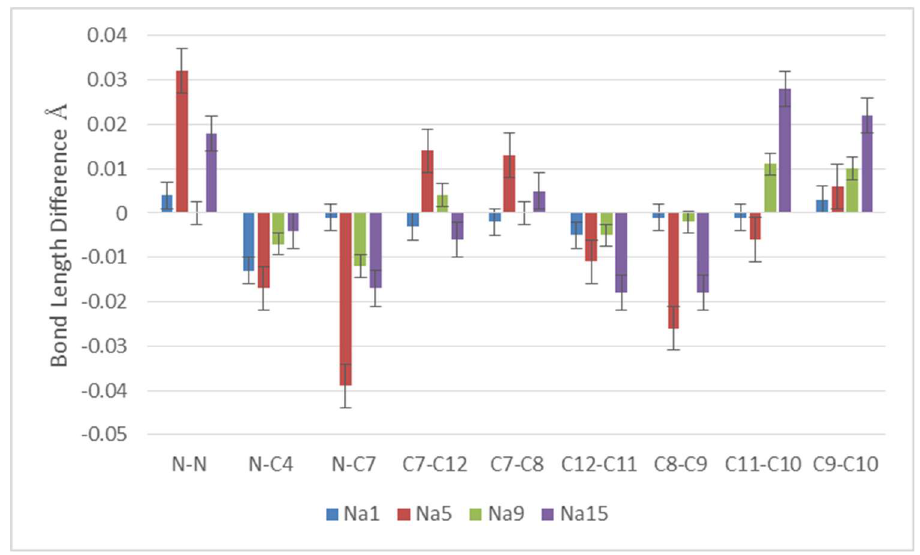
Figure 11. Selected bond length differences between Na salts and azobenzene (Na salt–azobenzene). For atom numbering, see Figure 2. Table 2. Bond length differences between Na5 and azobenzene (Na5–azobenzene).